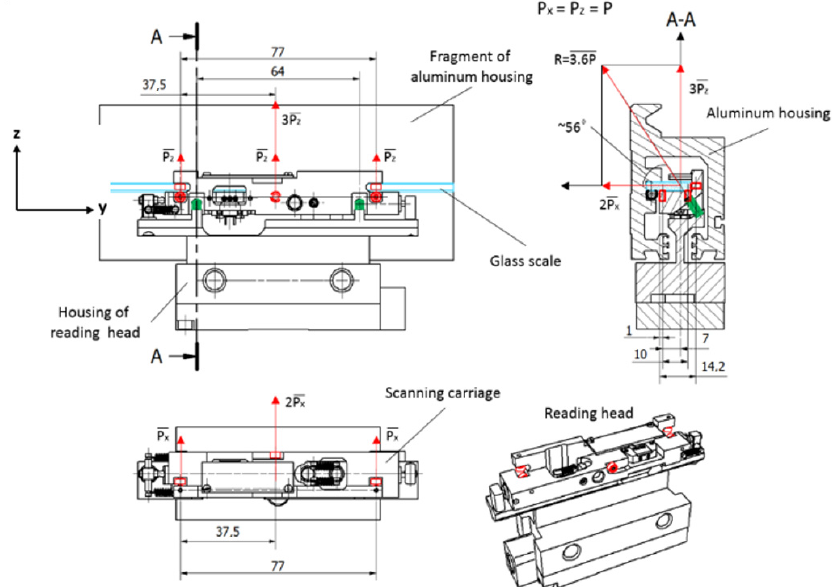
Figure 5. Mechanical construction of the reading head with the marked acting forces. (For better visualization, the glass scale is marked in the drawing in light blue, the compression springs in green, and the ball bearings and acting forces in